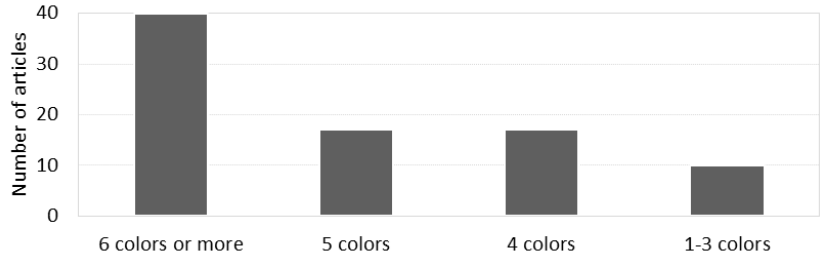
Figure 10. MP colors identified in the analysis.